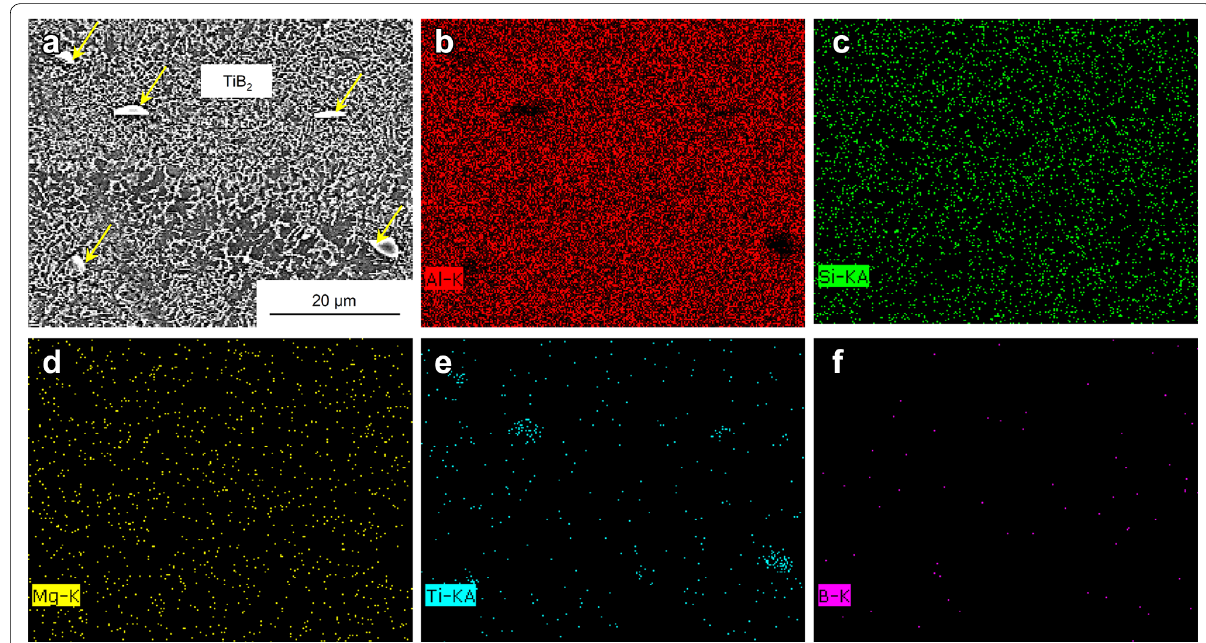
Figure 7 a FE-SEM image showing the dispersion morphologies of micro-TiB 2 particles in the matrix at optimized laser processing parameter ( P 400 W and v 2000 mm/s); b – f EDX element mappings of ( a ) showing the distribution of Al, Si, Mg, Ti, B, =